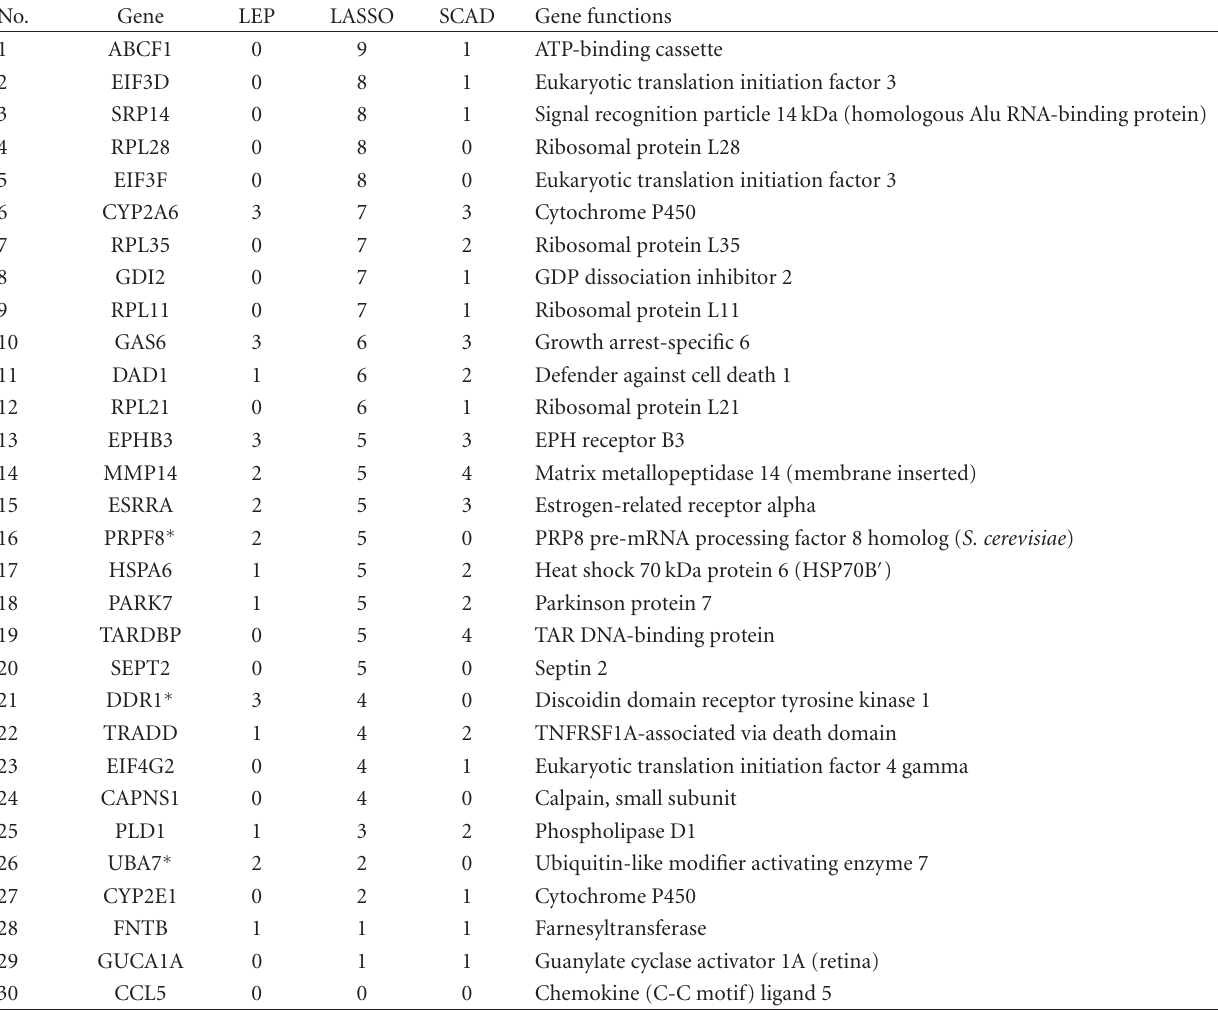
Table 2: The number of edges connected with each gene in GSE6536 data